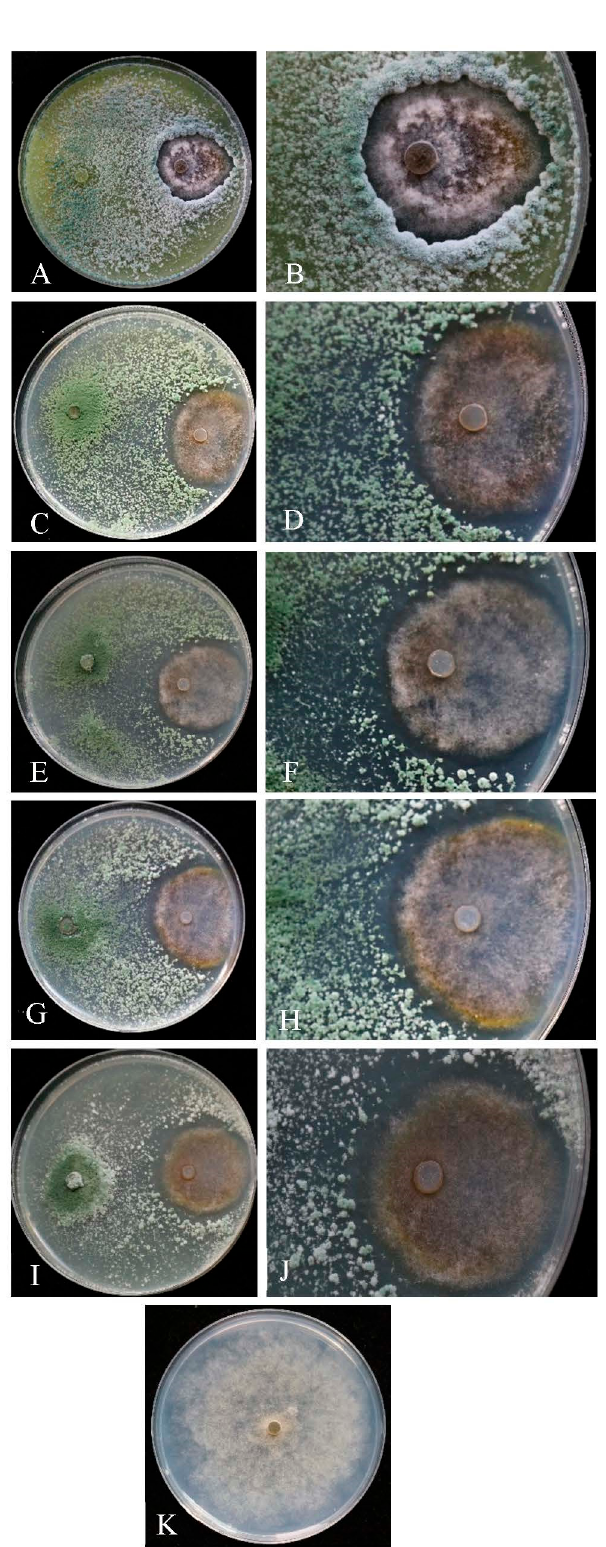
Figure 6. Antagonistic activity levels of five Trichoderma strains against Monilia yunnanensis after dual culture at 6 days: ( A , C , E , G , I ) the antagonistic activity levels of Trichoderma strains T6, B3, D5, J1, and D6 against M. yunnanensis in dual culture, respectively; ( B , D , F , H , J) the interactions of Trichoderma T6, B3, D5, J1, and D6 colonies with M. yunnanensis , respectively; ( K) the normal colony of M. yunnanensis (control) .